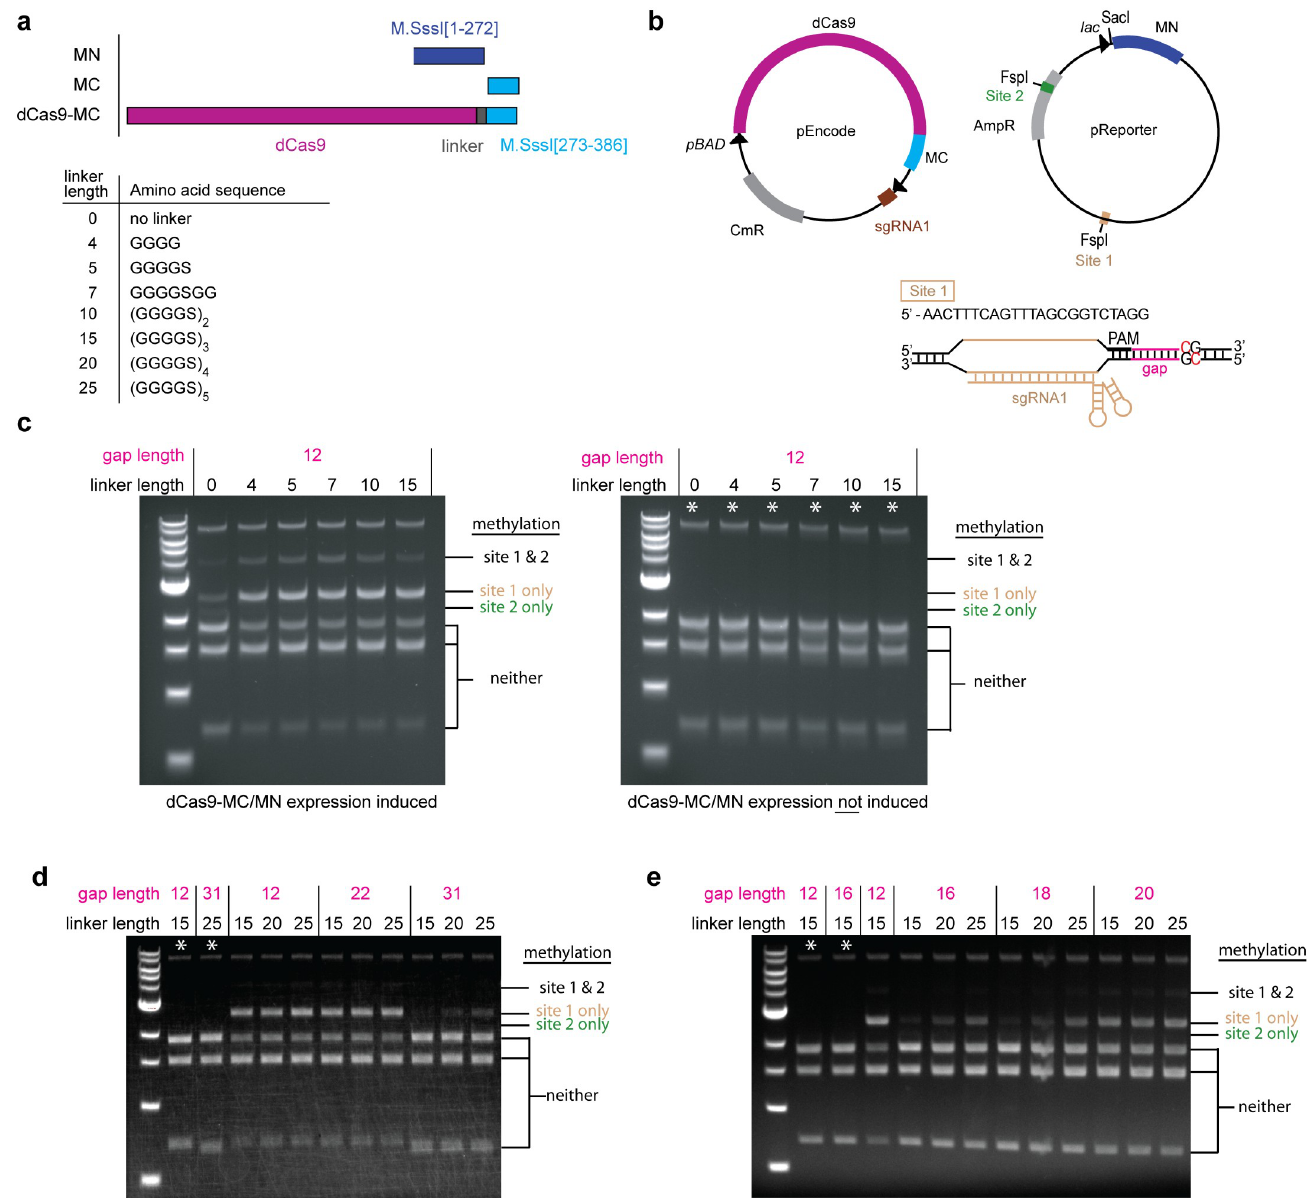
Fig 1. Effect of linker length on methylation targeting in ER2267 E . coli cells. (a) Schematic of protein constructs and linkers used in E . coli studies. (b) Methylation was tested in a two plasmid ER2267 system with inducible dCas9-MC/MN genes and constitutively expressed sgRNA1. Each of site 1 and site 2 contains a CpG site imbedded in an FspI site to allow screening of methylation by FspI endonuclease. Plasmid DNA isolated from cells containing this plasmid pair and expressing sgRNA1 were subjected to in vitro restriction enzyme protection assay to test (c) the effect of shortening the linker length on methylation at a fixed gap distance (d) the effect of lengthening the linker on methylation at longer gap distances, and (e) the effect of lengthening the linker on methylation at gap distances for which the dCas9-MC/MN enzyme with the 15 aa linker is ineffective at methylation. sgRNA1 is designed to target methylation to site 1. The sizes of bands corresponding to methylation at the indicated sites are specified to the right of the gel images. The asterisk indicates that dCas9-MC/MN expression was not induced. All plasmid DNA was digested with SacI (to linearize the plasmid) and FspI (to test for methylation at sites 1 and 2). Plasmid pEncode lacks FspI restriction enzyme site and is the band at the top of the